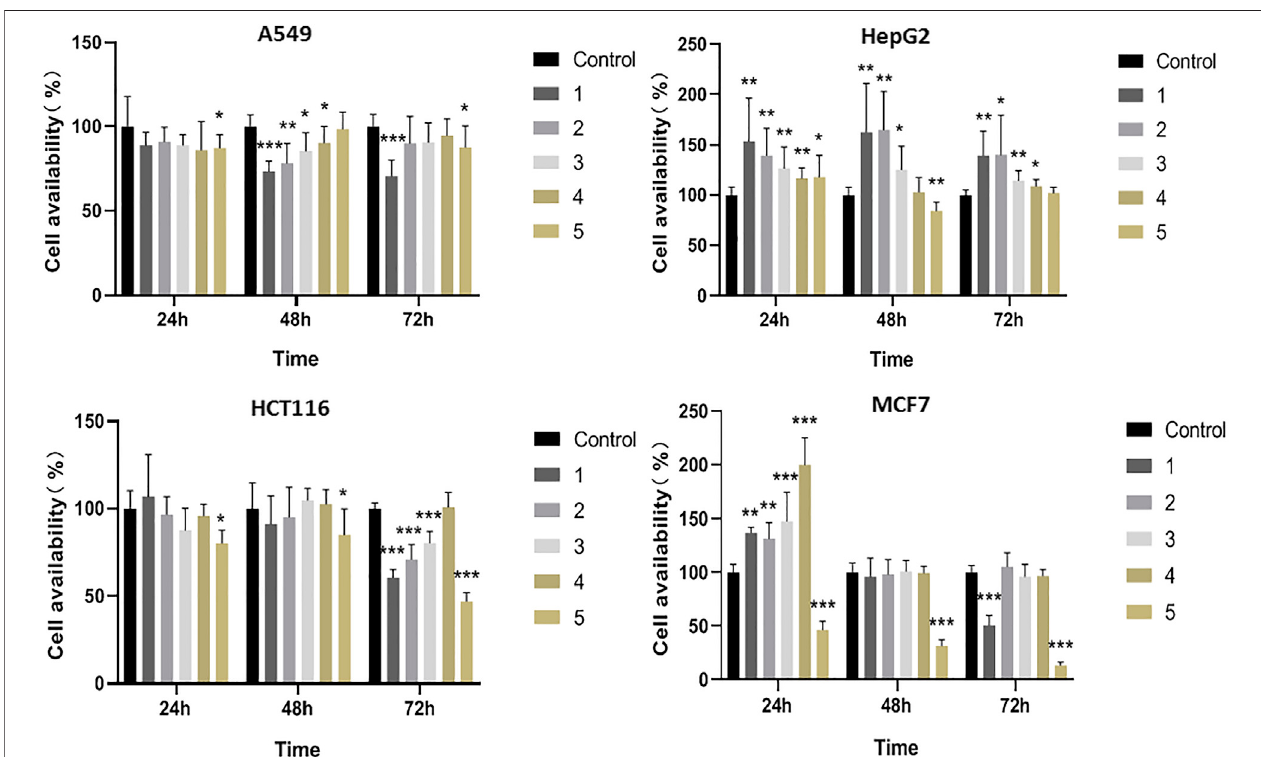
FIGURE 2 | The cytotoxic effects of test compounds 1 – 5 against A549, HepG2, HCT116 and MCF7 cells.